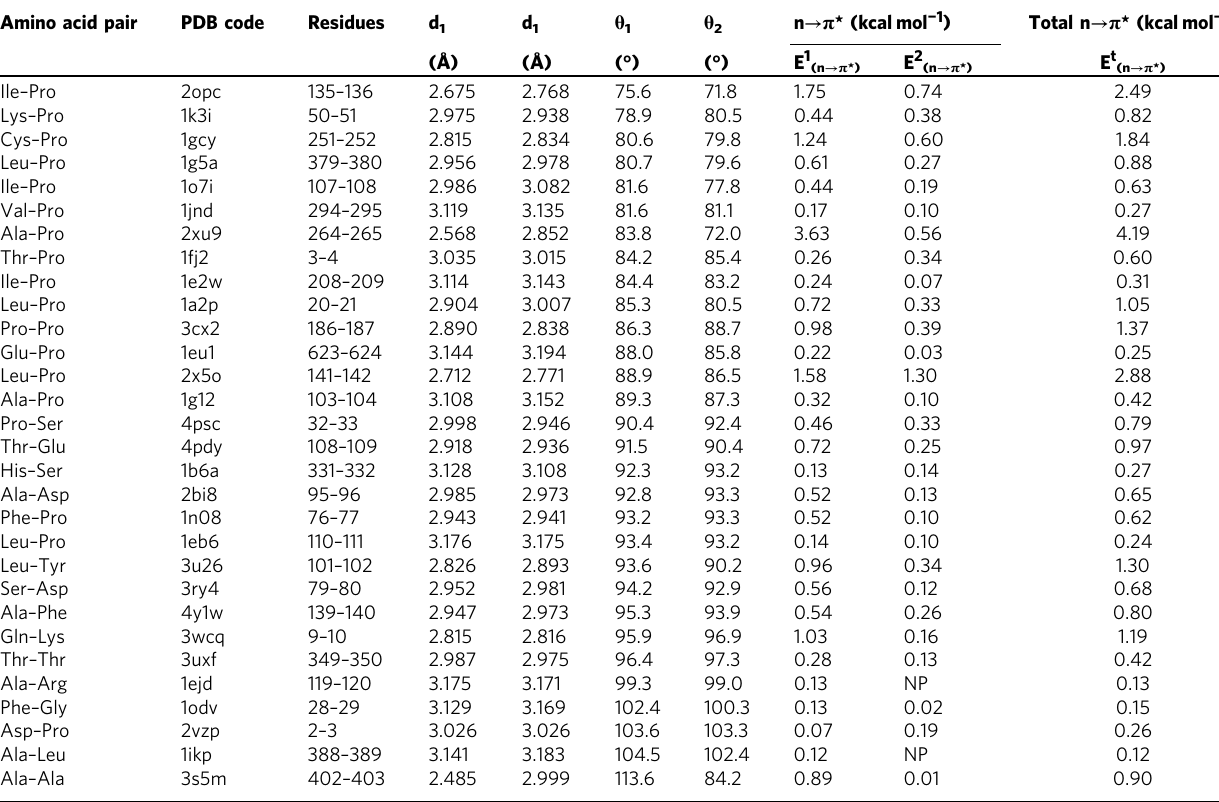
Table 3 X-ray crystallographic structural and NBO data for amino acid pairs from the PDB Amino acid